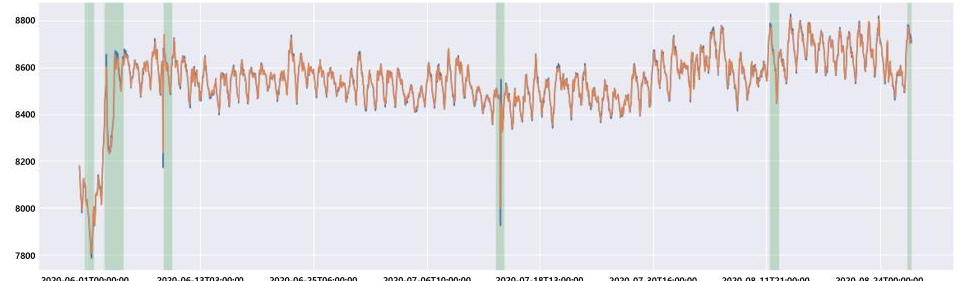
Figure 8. Anomaly detection result using ARIMA in building power usage data.